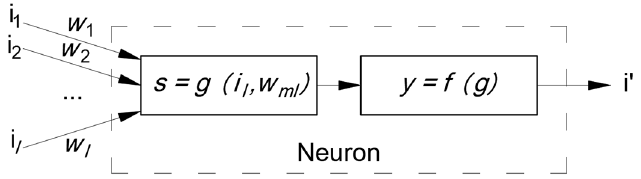
Figure 2. Construction of a typical neuron found in the hidden layer or output layer.